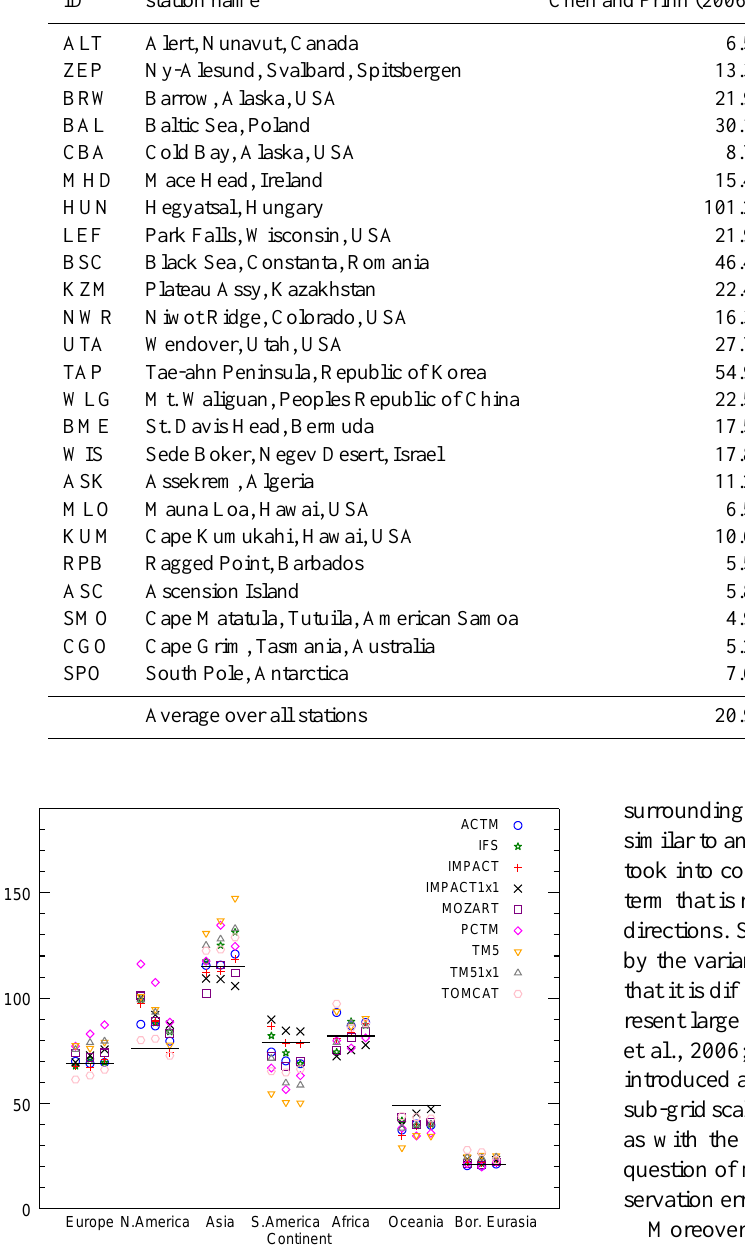
Fig. 15. Regional methane estimates for every inversion using TransCom model outputs as synthetic observations in three net- work configurations. Estimates for seven continental regions (Eu- rope, North America, Asia, South America, Africa, Oceania and Boreal Eurasia) are shown. For every continental region, the first (second and third) column represents the estimates in the NET1 (NET2 and NET3, respectively)